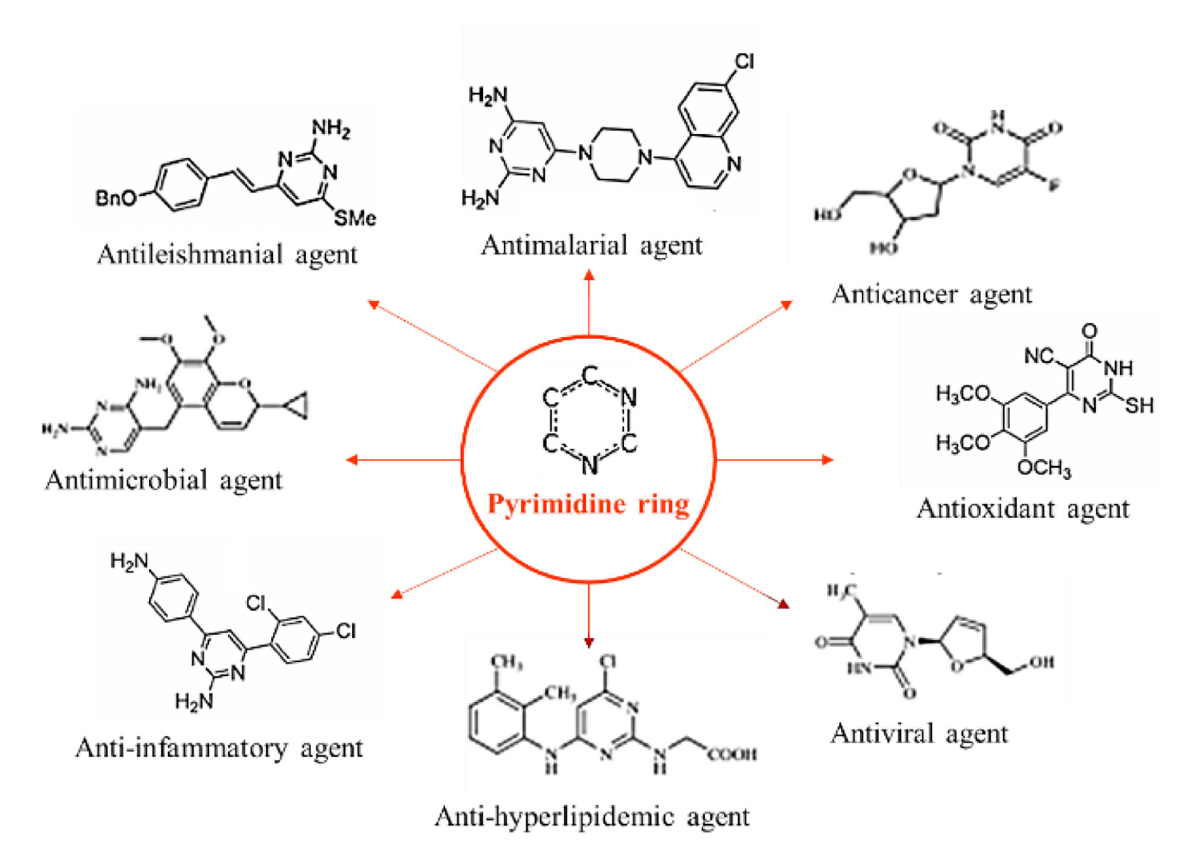
FIGURE2 Wide range of potential functions of pyrimidine derivatives in several health